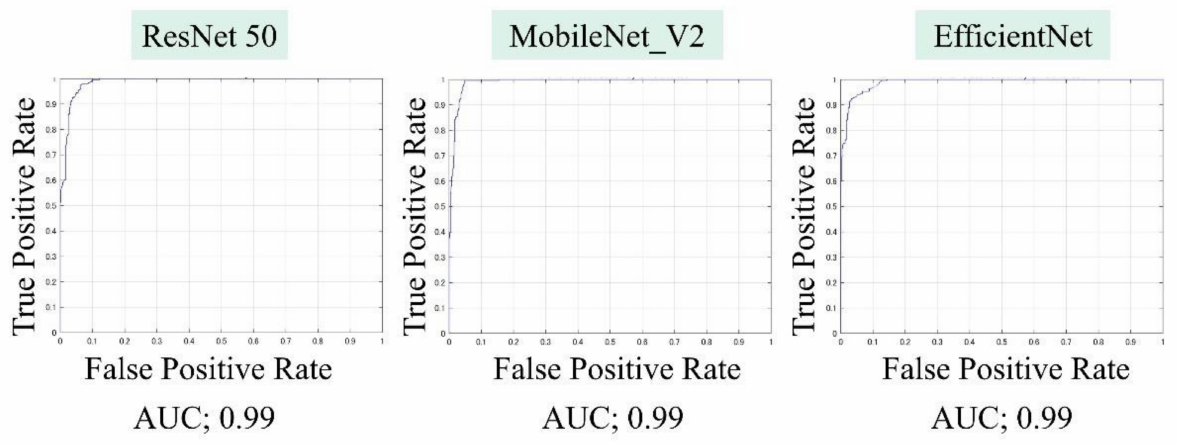
Figure 8. Area under the curve (AUC), based on the receiver operating characteristic (ROC) curve, was high for all learning models.